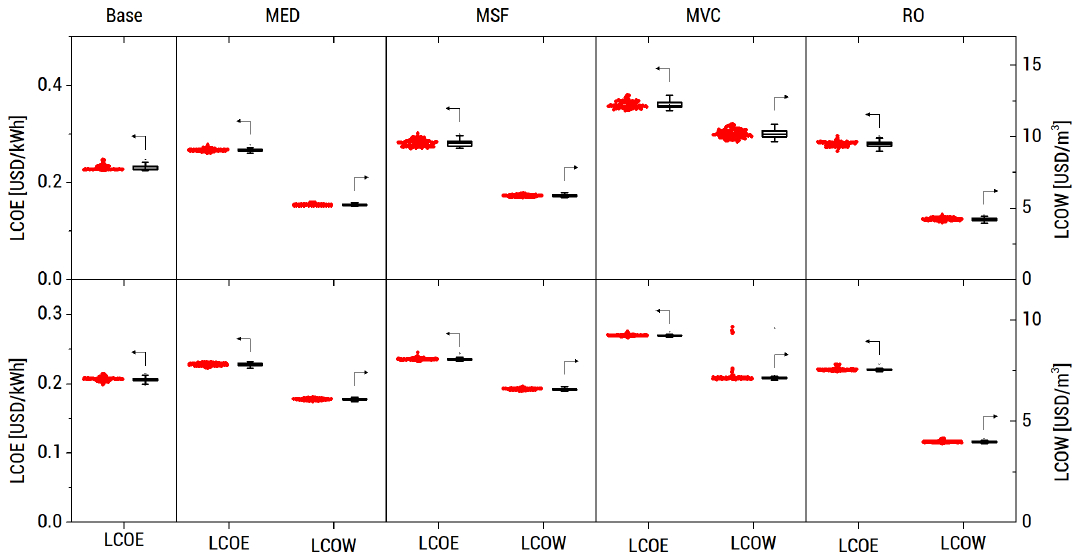
Figure 16. Distribution of optimum sizes of water storage and desalination unit on Camasusu Island (top) and Lubang Island (bottom) at −25% overnight fuel price. There is high uncertainty in the optimum water storage sizes in all systems on both islands.